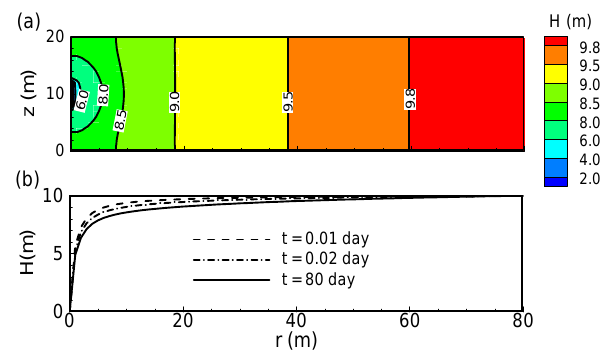
Fig. 3. The mean head distribution for the screen opened in the central portion of the well: (a) the r and z two-dimensional head distribution for t = 80 day, and (b) the snapshots of head centerline profiles along z=10m for different simulation times.